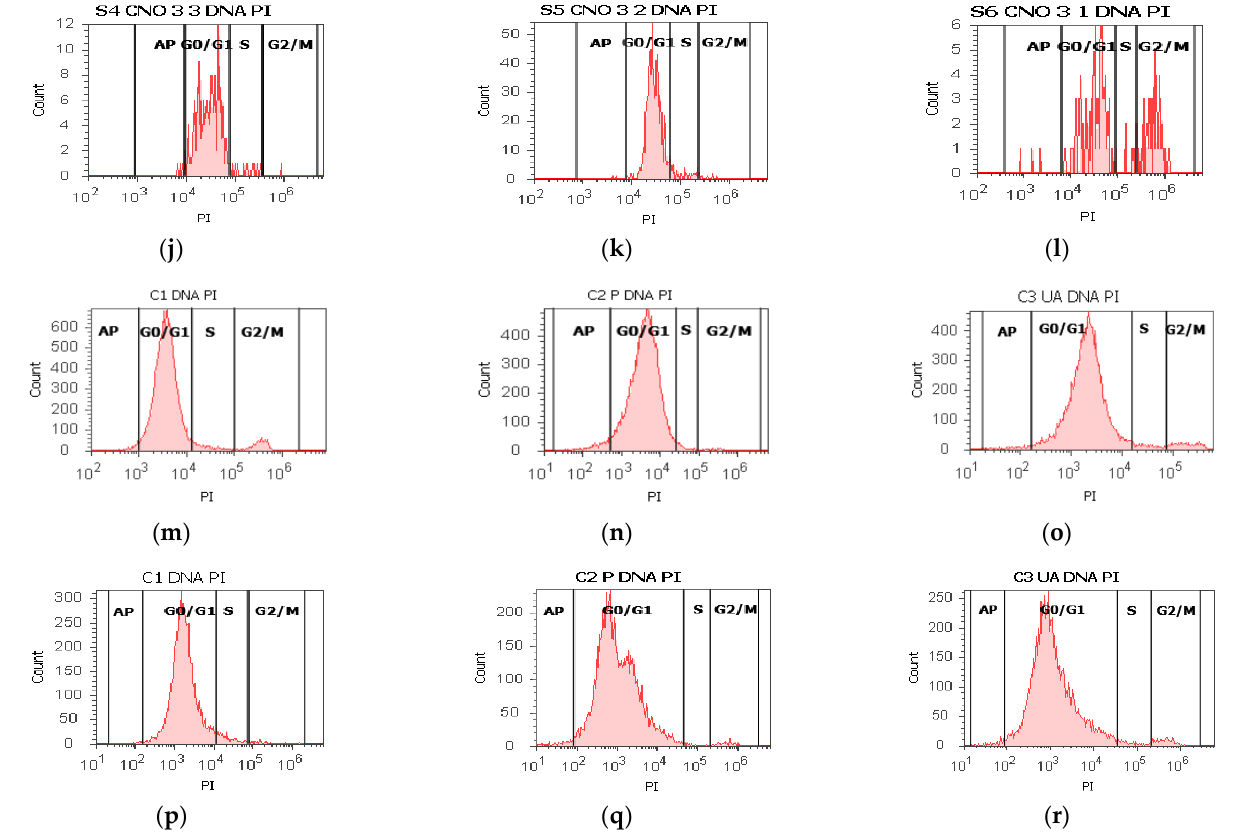
Figure 6. Cell cycle in blood cells ( a – c , g – I , m – o ) and CLS-354 tumor cells ( d – f , j – l , p – s ) after 24 h exposure to different concentrations [3:3; 3:2; 3:1] of U. barbata extract in canola oil (UBO) ( a – f ) and canola oil (CNO) ( g – l ) compared to C1, C2P, and C3UA controls ( m – r ). C1 — 1% DMSO